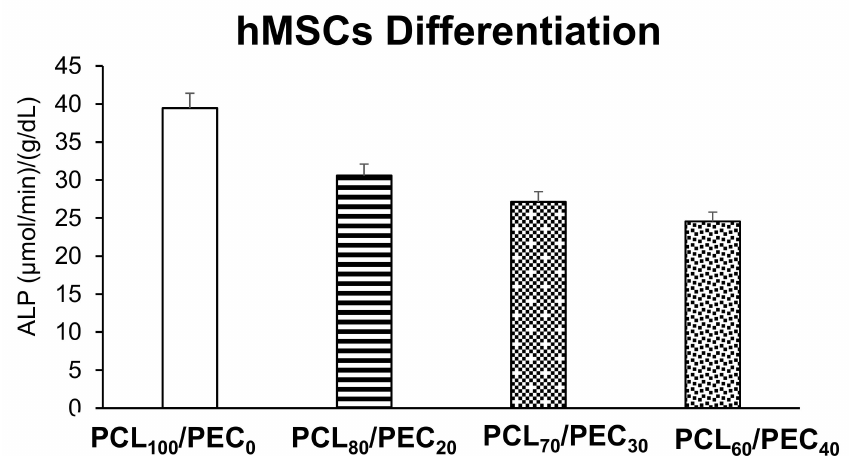
Figure 11. Intracellular alkaline phosphatase (ALP) activity expressed as µ mol/min/g/dL pro- tein, normalized by total protein content of human mesenchymal cells after 7 days of culture on PCL/PEC